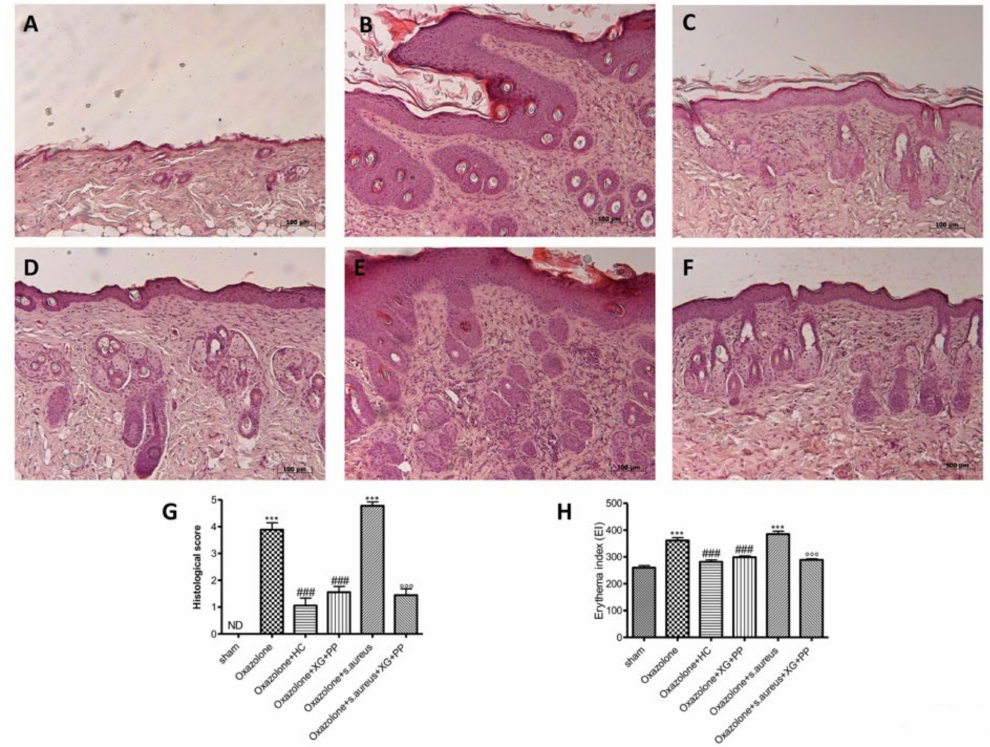
Figure 1. E ff ects of xyloglucan (XG) and pea protein (PP) on histological damage and erythema index induced by oxazolone and S. aureus : No histological variations have been found in the epidermis tissue collected from sham-operated mice ( A ) (see histological score). An extensive damage to the epidermis was evaluated in oxazolone-treated mice ( B ) (see histological score) and in oxazolone + S. aureus treated mice ( E ) (histological score) stained with hematoxylin–eosin (H&E).